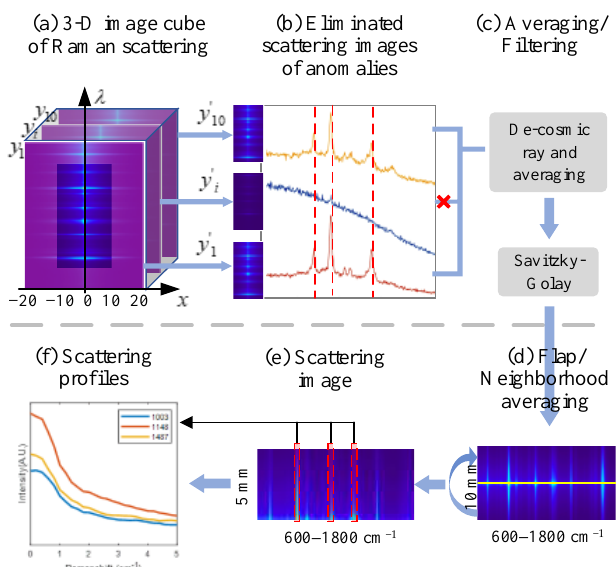
Figure 2. Key steps in the pre-processing of Raman scattering images. ( x is the spatial position on both sides of the laser spot on each scanning line, y is the line-scan image of shrimp at different acquisition positions, and λ is the waveband of the Raman spectrum.)